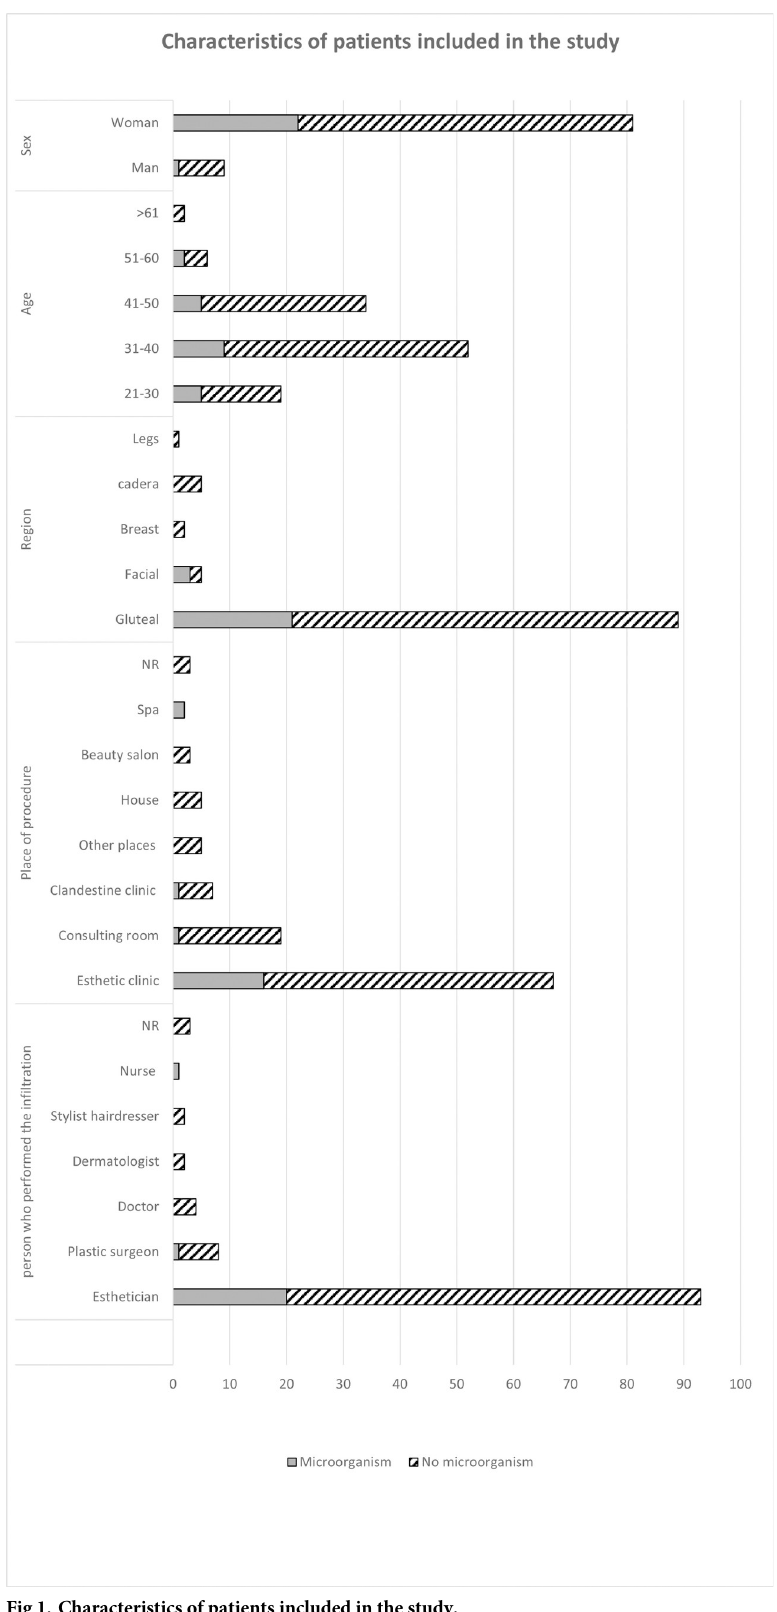
Fig 1. Characteristics of patients included in the